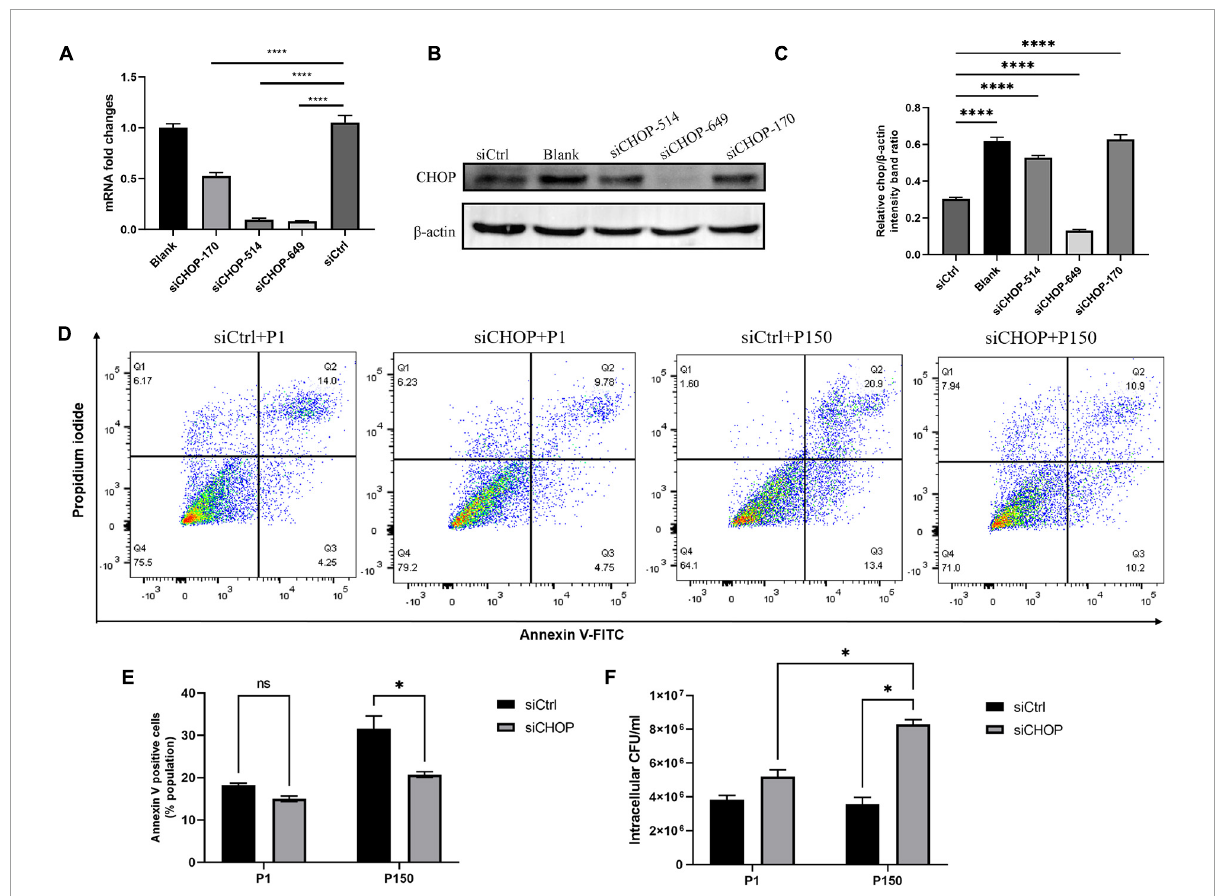
FIGURE6 Effect of CHOP knockdown with siRNA interference on apoptosis and intracellular survival of M. bovis P1 and P150. qRT-PCR (A) and western blot analysis (B,C) were performed to evaluate the expression of CHOP in transfected BoMac cells. (D,E) Apoptosis assay by flow cytometry showed that CHOP knockdown significantly decreased the apoptosis of BoMac cells induced by P150 infection, but not by P1 infection. (F) Quantification of intracellular survival of M. bovis P1 and P150 in BoMac cells. Cells were harvested at 24-h post-infection with M. bovis and bacteria number was determined by gentamicin invasion assay. Data are presented as the means ± SD of the results from three independent experiments. A significant difference was assessed by one-way ANOVA relative to the control. ∗ p < 0.05 and ∗∗∗∗ p <